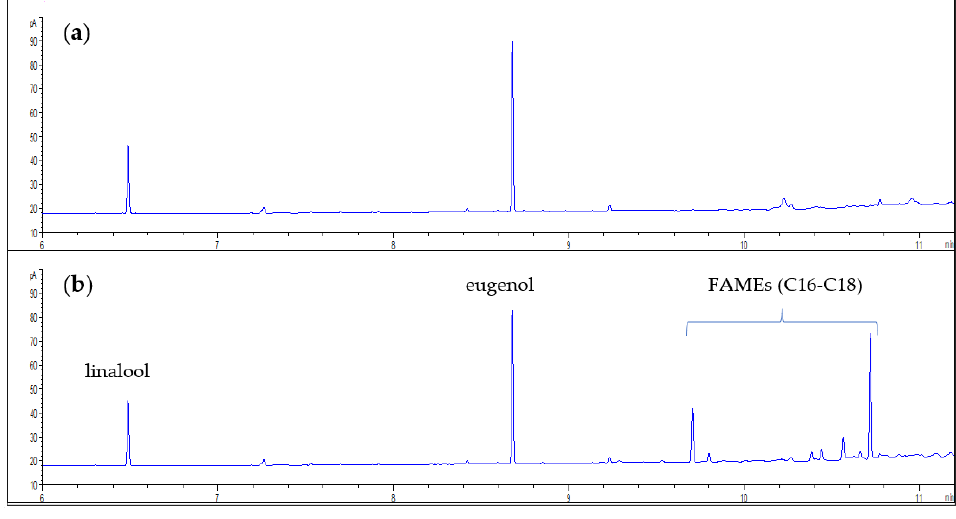
Figure 1. ( a ) Chromatogram obtained from the direct GC analysis of hexane extract; ( b ) Chromatogram obtained by the hexane extract after